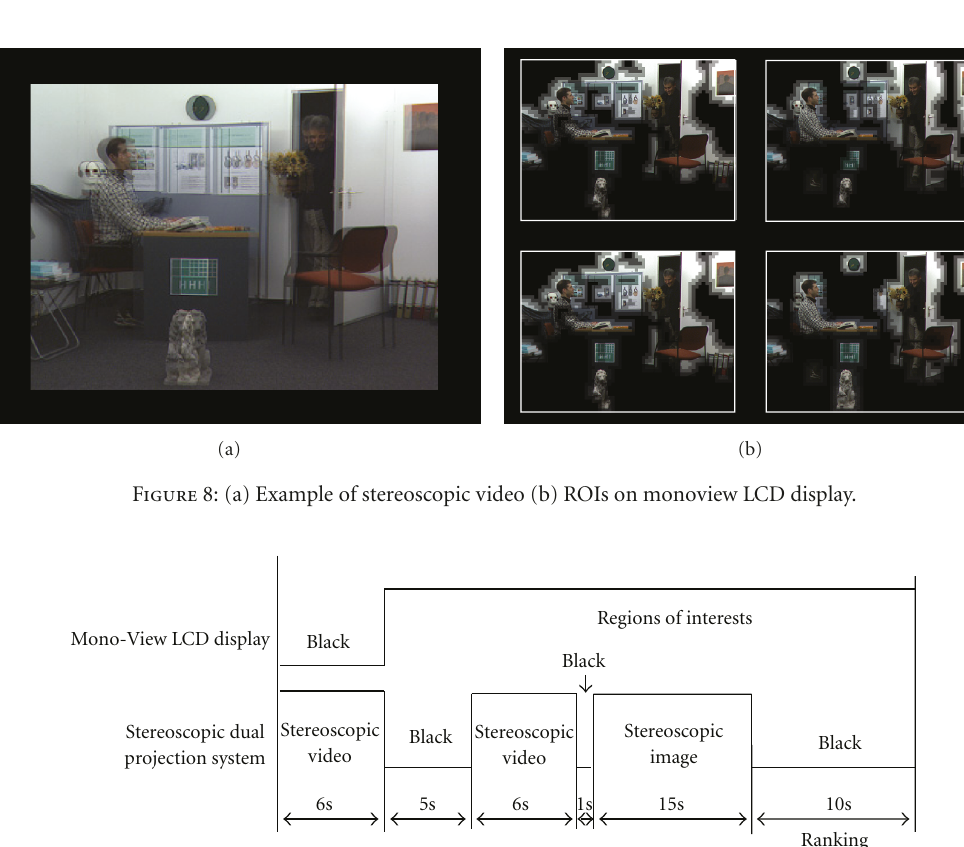
Figure 9: Displaying time interval of stereoscopic video and the extracted